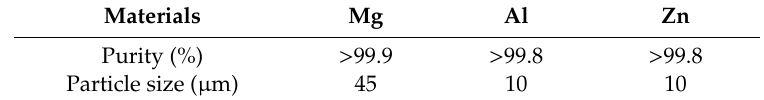
Table 1. The specific parameters of the matrix powders used in this study.